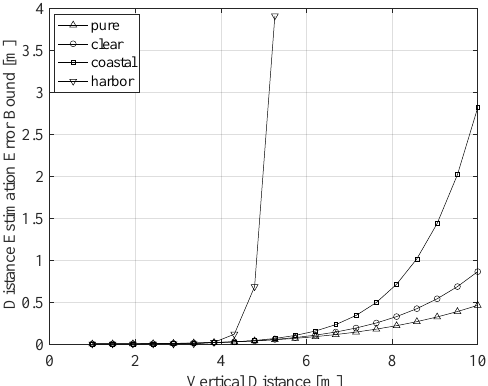
Figure 8. Maximum achievable estimation error (m) versus the vertical distance, for different water